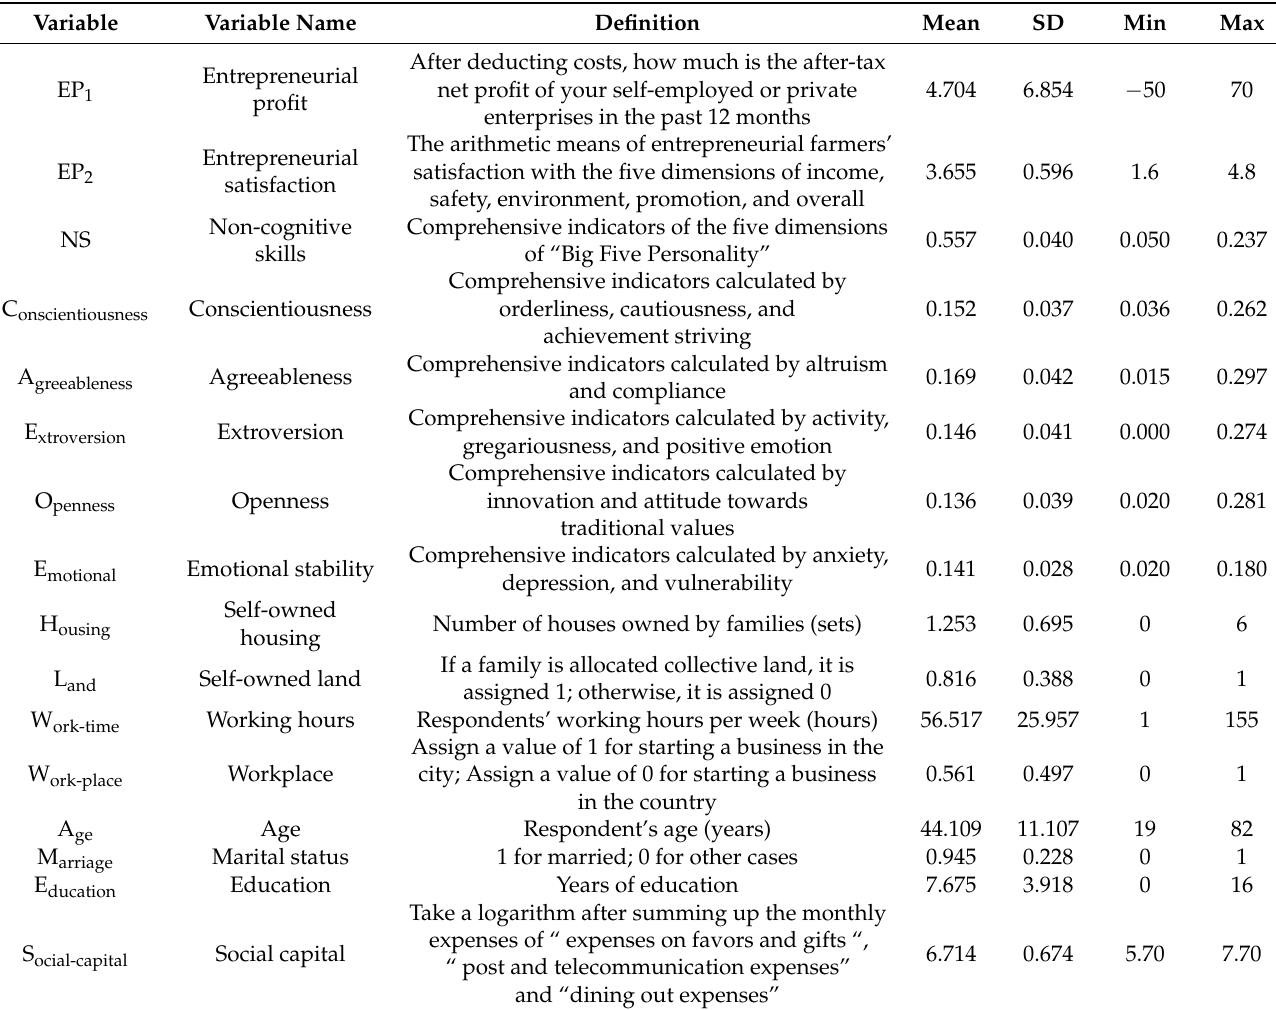
Table 2. Variable list and descriptive